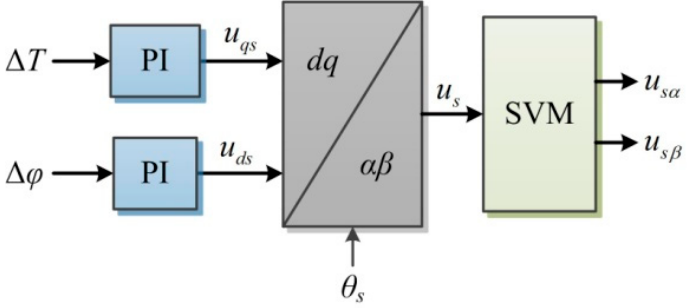
Figure 2. Schematic diagram of SVM-DTC.